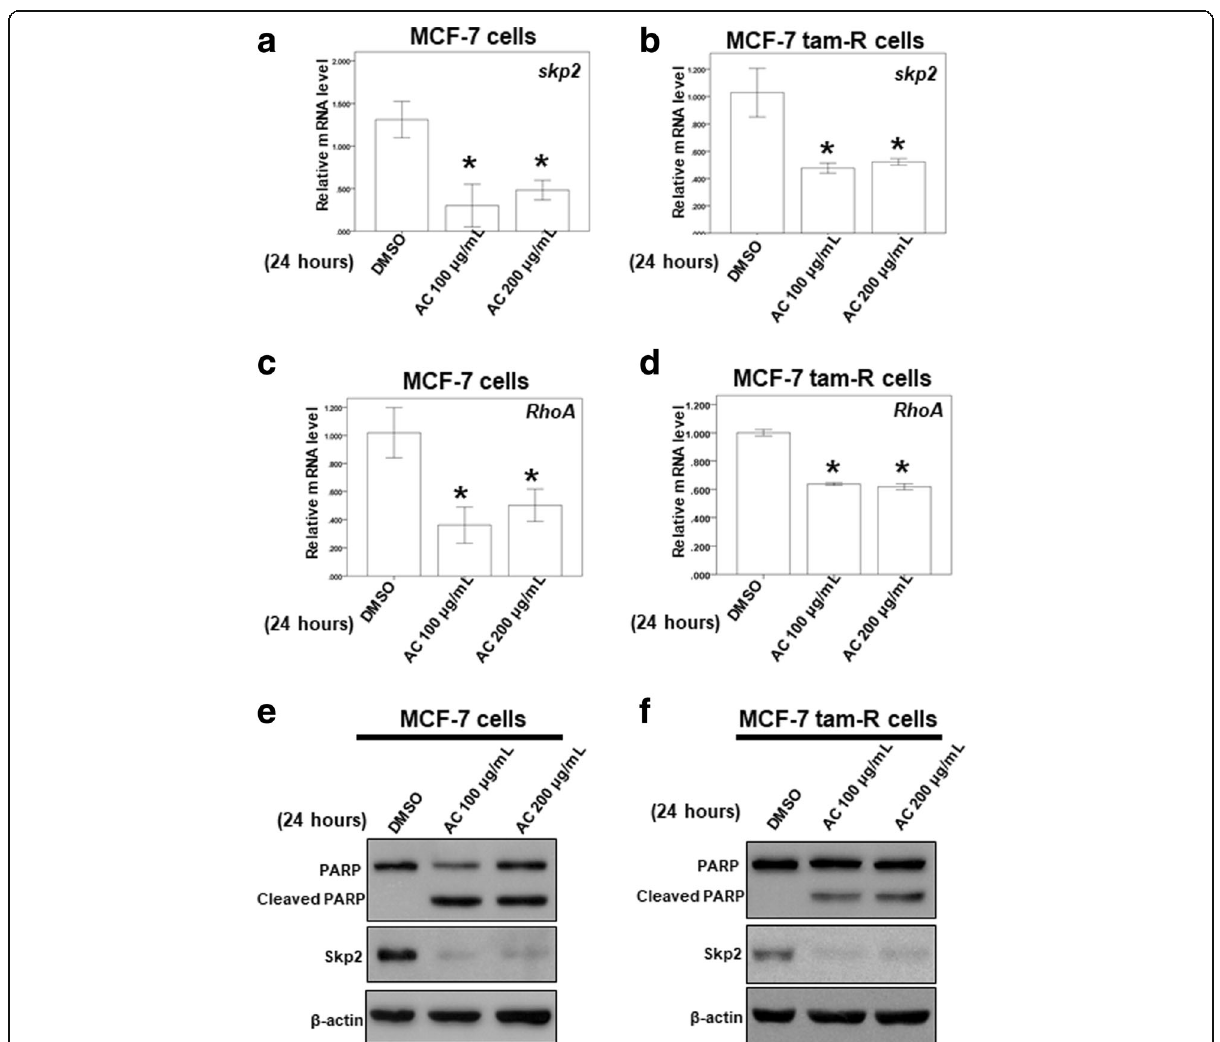
Fig. 4 The effect of AC on the mRNA expression of skp2 and RhoA and the protein expression of PARP and skp2. a-d Total mRNA was extracted from the two breast cancer cells after treat without or with indicated drugs for 24 h. The coding regions of human Skp2 and RhoA were used as probes for real time polymerase chain reaction analysis. e, f Total cell extracts of the two breast cancer cells were harvested from cells treated with DMSO or indicated concentrations of AC for 24 h. The protein was immunoblotted with polyclonal antibodies specific for PARP or Skp2. β - actin was used as an internal loading control. (Error bars = mean ± S.E.M. Asterisks (*) mark samples significantly different from DMSO group with p <